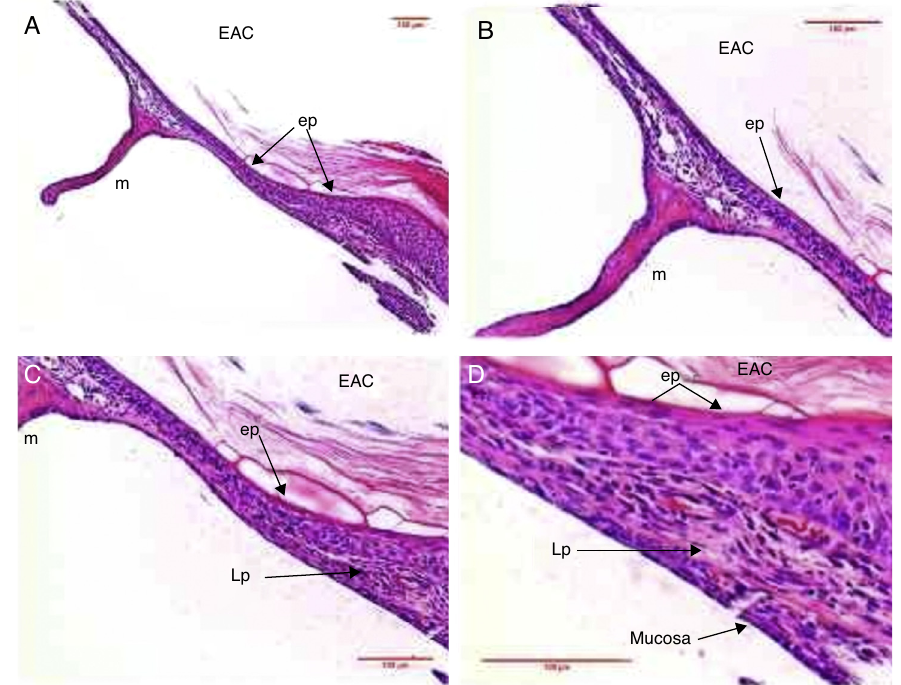
Figure 5 Histological section images of rat TM 7 days after traumatic perforation, stained with HE. EAC, external auditory canal; m, malleus handle; ep, epithelial layer; Lp, lamina propria; mucosa, mucosal layer. Image (A) shows a magnification of 100 × ; (B and C) 200 × and (D) 400 ×